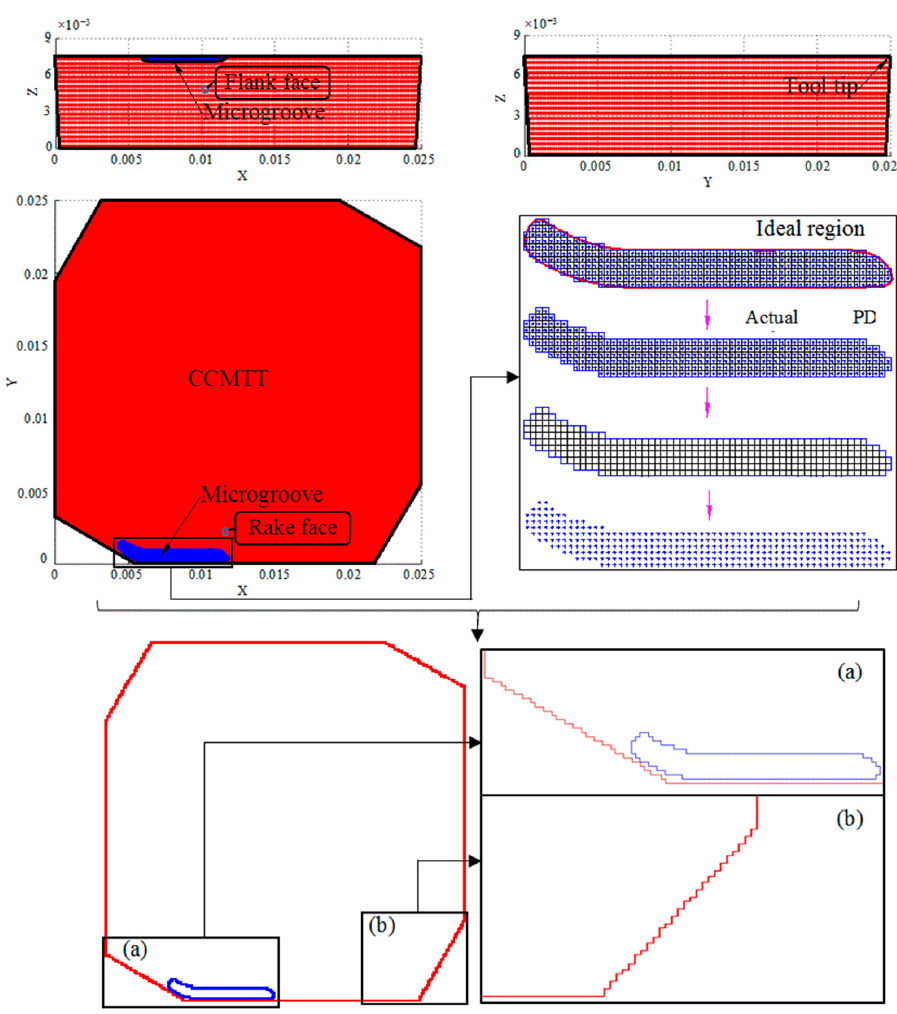
Figure 6. PD model of the CCMTT: (a) region 1 and (b) region 2.